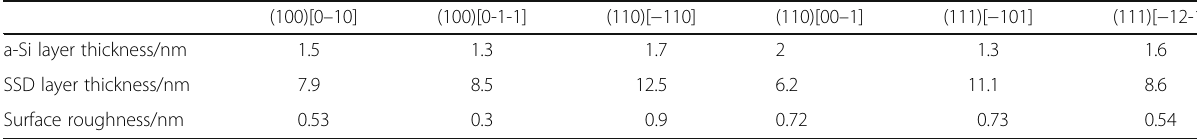
Table 2 Surface integrity on different crystal